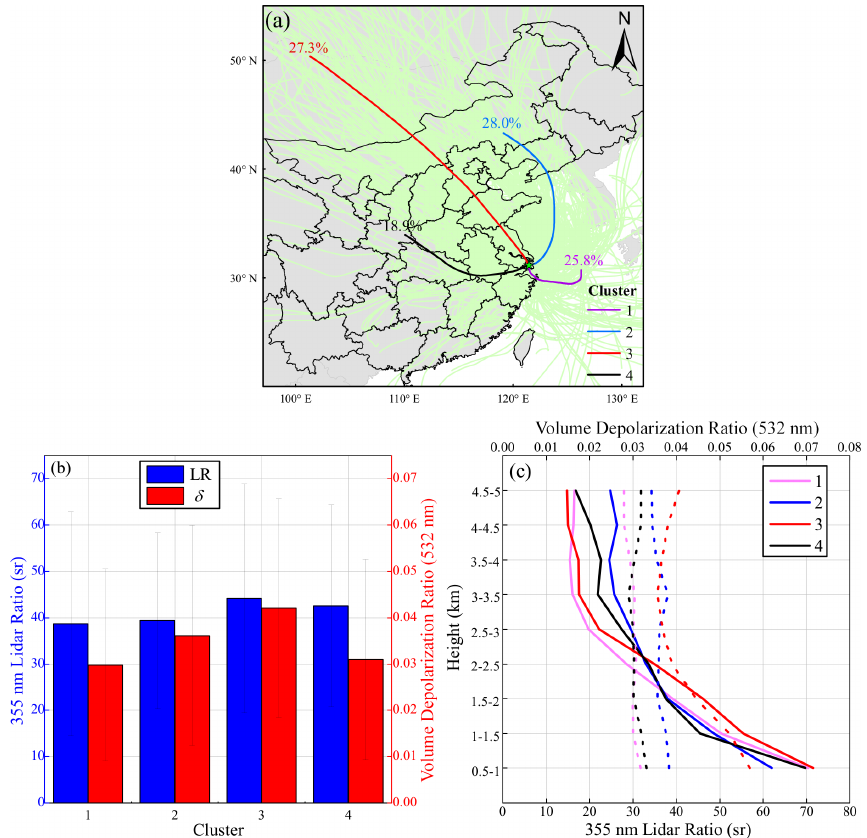
Figure 7. (a) Seventy-two-hour back trajectory cluster analysis. (b) Mean values of LR and δ corresponding to different air masses. (c) The average of LR and δ at different heights corresponding to different air masses; the solid line is LR, and the dotted line is δ .